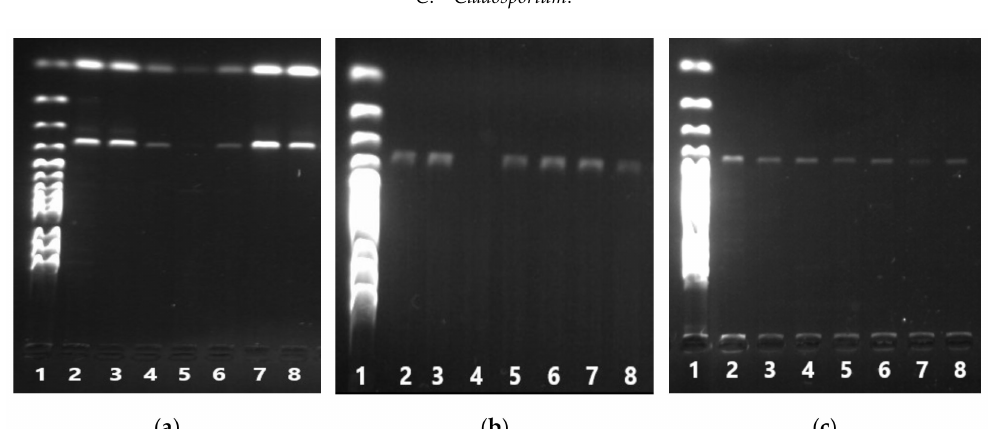
Figure 1. Detection of individual mold genera by PCR: ( a ) Cladosporium spp. (87 bp; internal control 370 bp) Line 1: 100 bp ladder standard; Line 2: Cladosporium cladosporioides CCM F-348; Lines 3 to 8: isolates of Cladosporium spp.; ( b ) Penicillium spp. (336 bp) Line 1: 100 bp ladder standard; Line 2: Penicillium chrysogenum CCM F-362; Lines 3,5,6,7, and